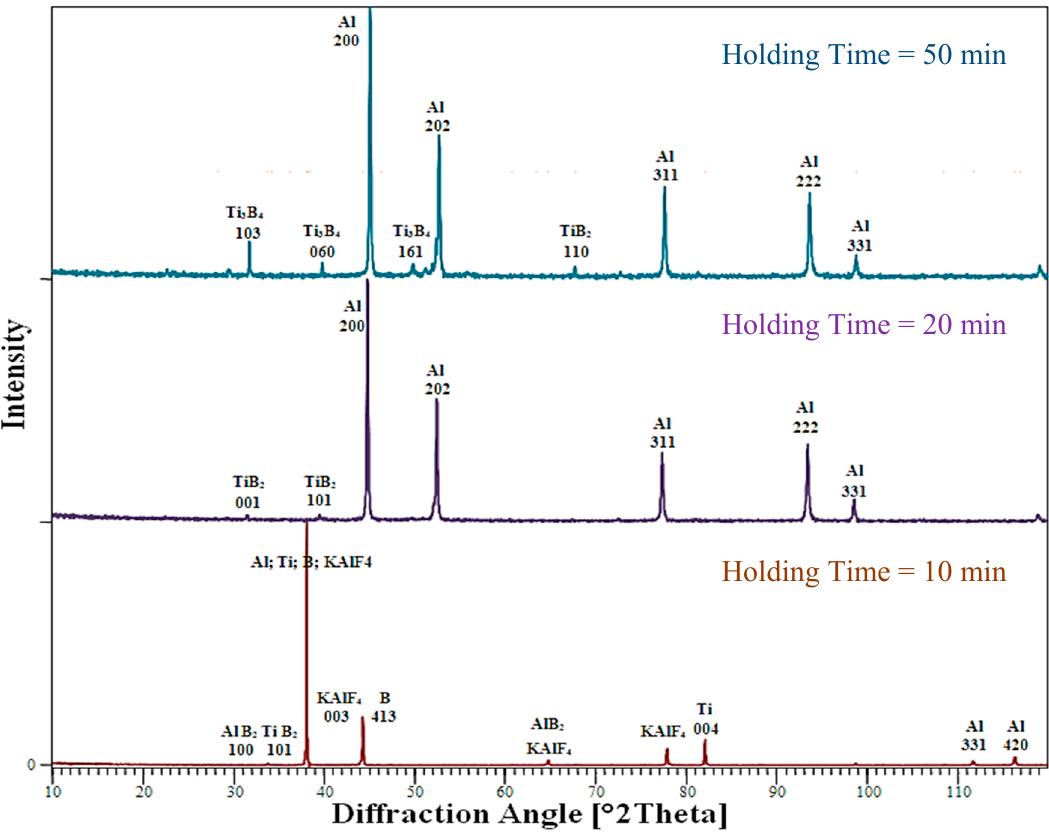
Figure 4. X ‐ ray diffraction (XRD) spectrum for Al ‐ 5%TiB 2 metal matrix composite for various holding Figure 4. X-ray diffraction (XRD) spectrum for Al-5%TiB 2 metal matrix composite for various holding time of melt. time of